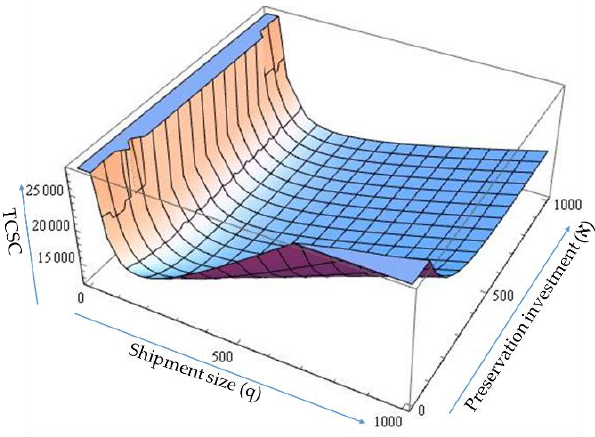
Figure A2. Graph of TCSC (q, ℵ ) at n *.